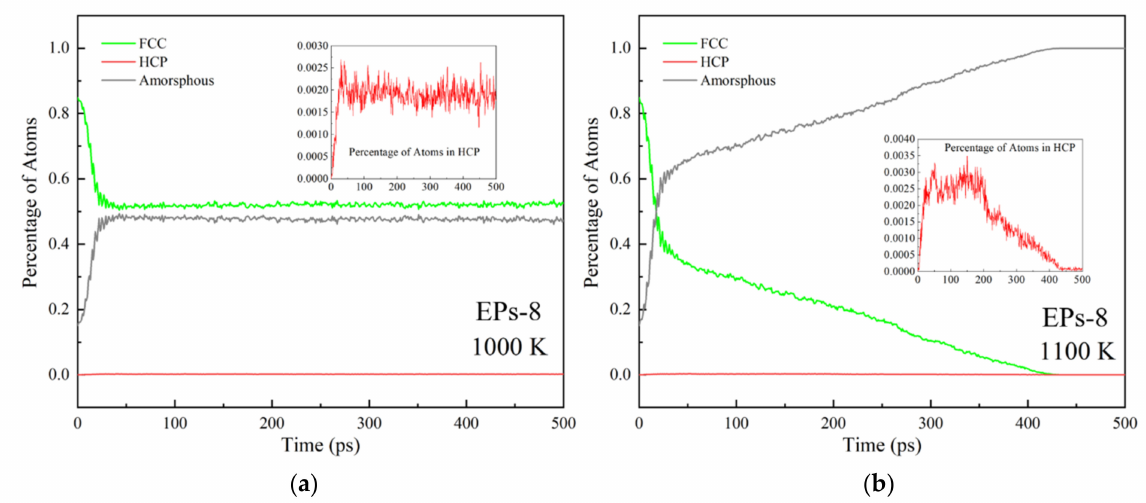
Figure 9. The percentage of atoms in different local structures corresponding to temperature during the premelting sintering process ( a ) and the liquid-phase sintering process ( b